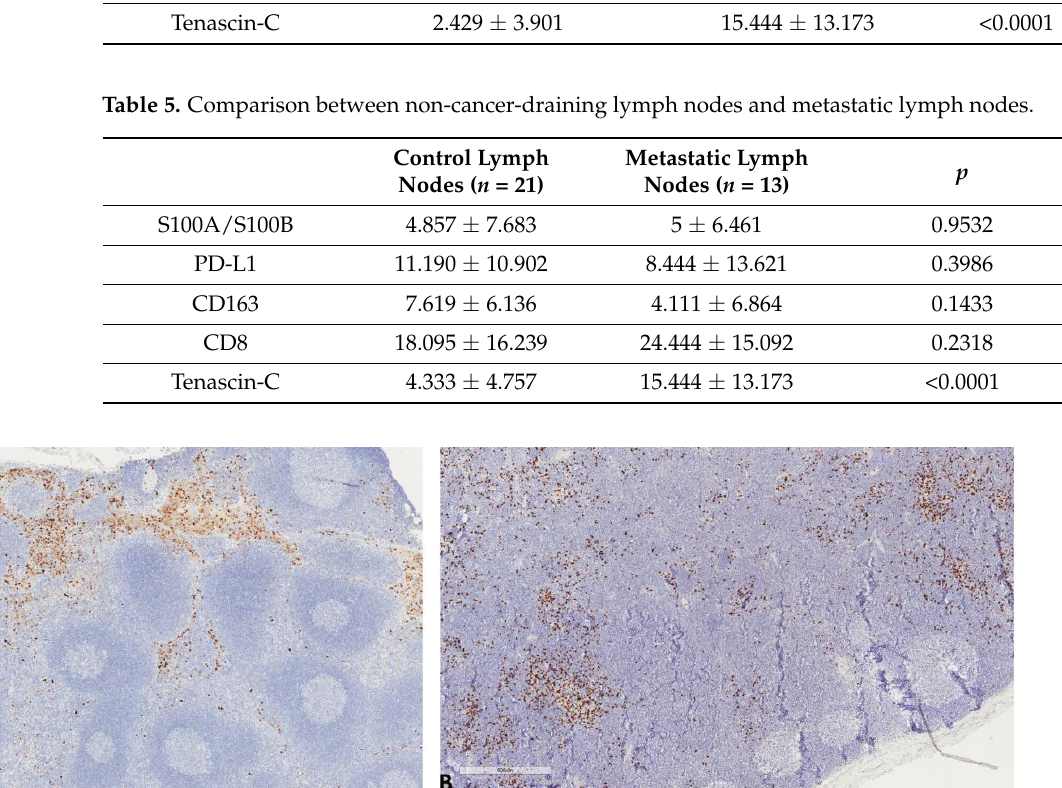
Figure 2. Representative microscopic images of CD8 expression in a normal cancer-draining lymph node ( A ) and a normal non-cancer-draining lymph node ( B ). Figure 3. Representative microscopic images of CD163 expression in a normal cancer-draining lymph node ( A ) and a normal non-cancer-draining lymph node ( B ).